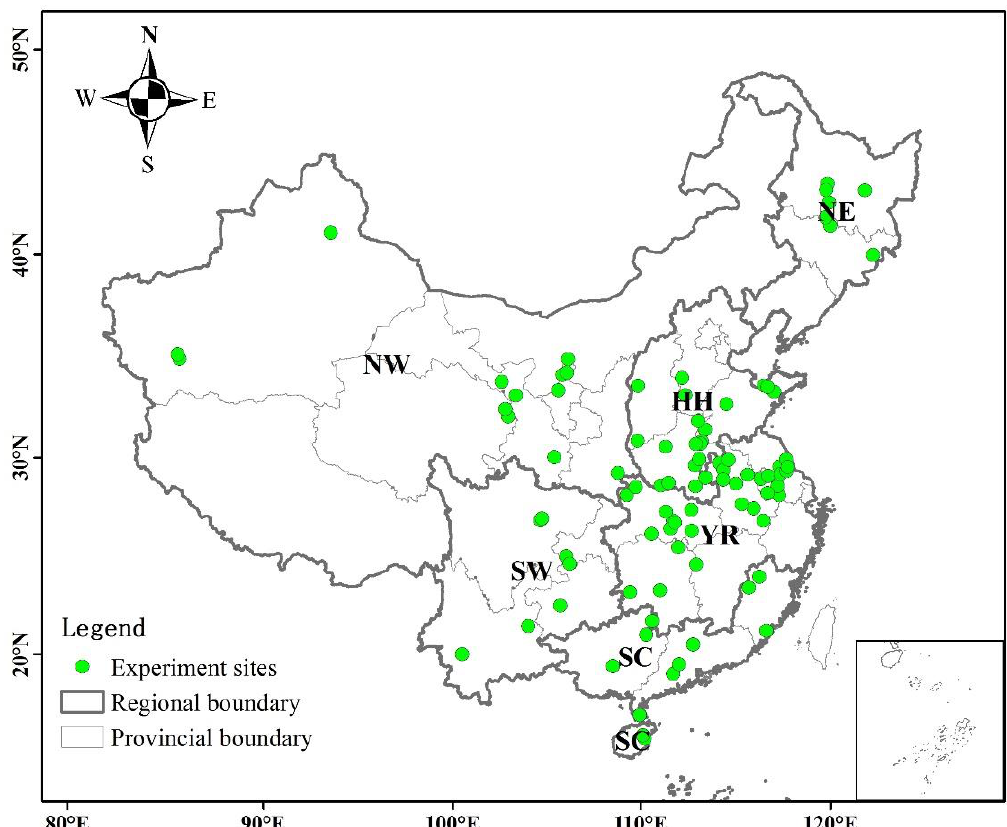
Figure 1. Distribution of long-term fertilization experiment sites in this study ( n = 91). The regional abbreviations shown are NE: northeast China; NW: northwest China; HH: Huang-Huai-Hai region; YR: middle and lower reaches of the Yangtze River; SC: South China and SW; southwest China.